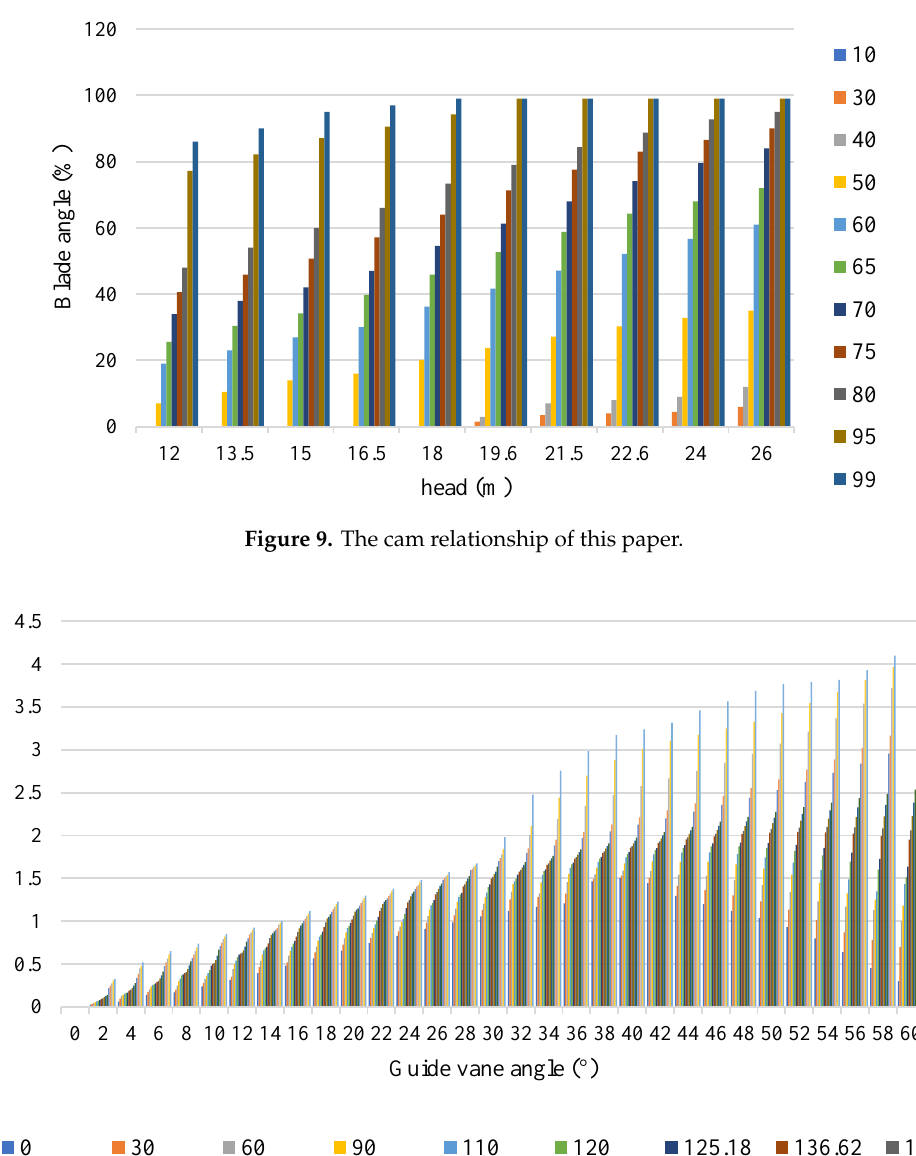
Figure 11. The relationship among the unit hydraulic torque, the guide vane opening, and the unit rotation speed when the blade angle is 14 degrees. 3. Model Validation In this chapter, we verify the accuracy of the hydroelectric unit model. To achieve this, the improved frequency dead zone is adopted. However, the feed-forward control is not used. In this experiment, the parameters of the simulation model are set according to the actual parameters of the